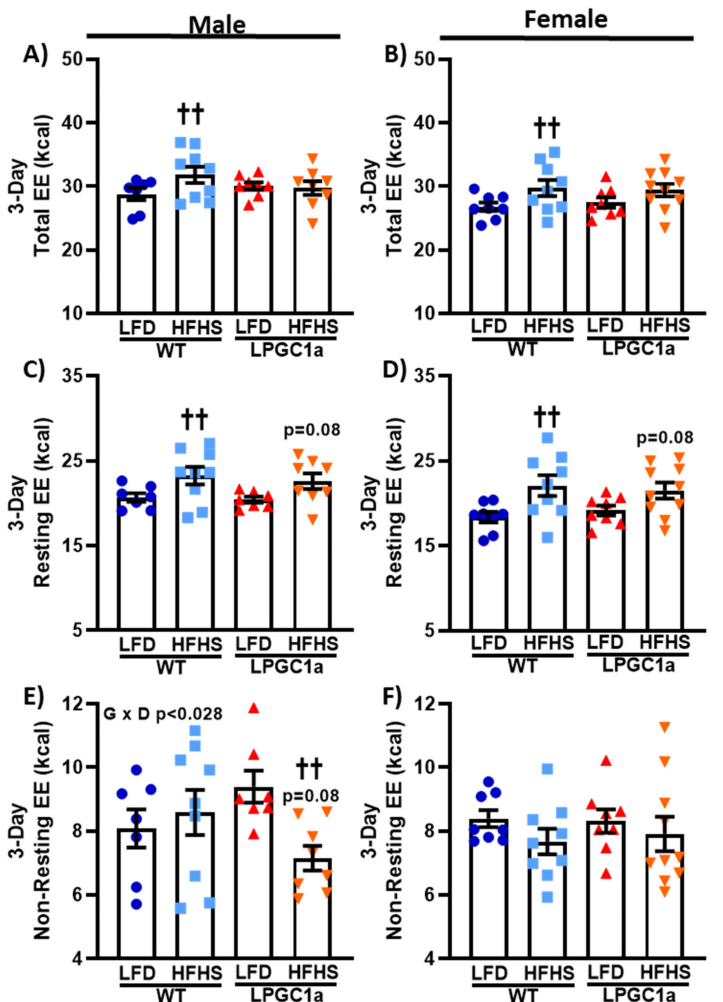
Figure 5. Reduced liver PGC1a blunt HFHS-induced increases in total EE in male mice due to lower non-resting EE. Indirect calorimetry during the 3 day diet intervention was used to determine total EE and its primary components: resting EE and non-resting EE in male and female WT and LPCG1a mice. Male and female data are presented for total EE ( A , B ), resting EE ( C , D ), and non-resting EE ( E , F ), respectively. Individual data points and the group means ± SEM are displayed ( n = 7–10). Genotype x Diet p < 0.05 interaction of genotype and diet, †† p < 0.05 LFD vs. HFHS within genotype. 3.5. Male LPGC1a Mice Fed a HFHS Diet Have Reduced Activity EE and Home Cage